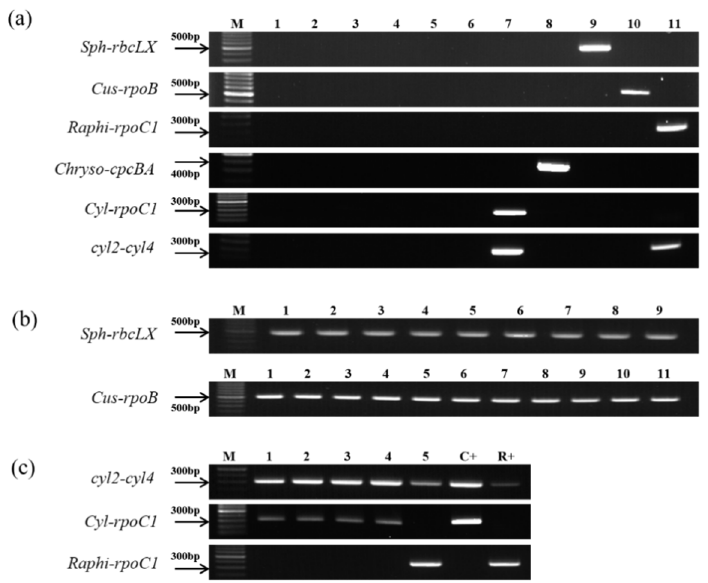
Figure 6. Agarose gel electrophoresis of polymerase chain reaction (PCR) products obtained with genus-specific primers. ( a ) PCR products from cultured nostocalean cyanobacterial strains (please